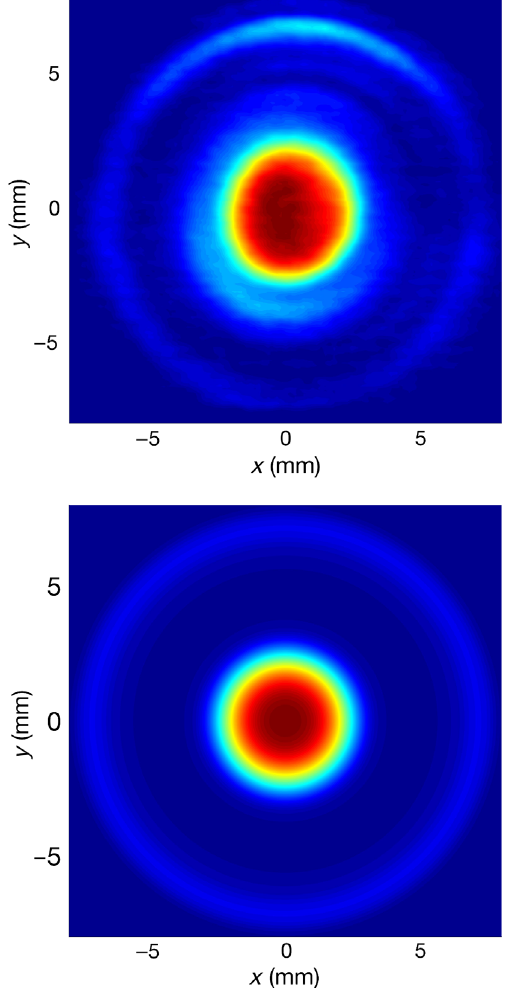
FIG. 2. A typical single-shot interference pattern of the FEL emission from a chain of six undulators. Top panel: Experiment. Bottom panel: Calculation (obtained assuming emission only at the fundamental